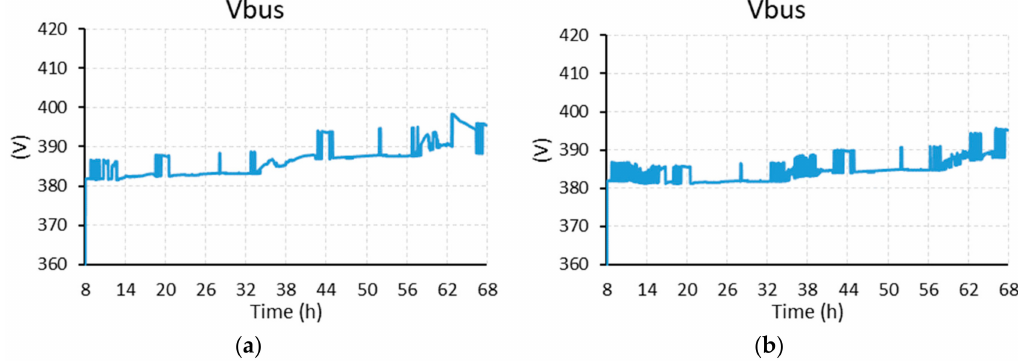
Figure 13. DC bus voltage for ( a ) stable solar profile and ( b ) fluctuating solar profile.